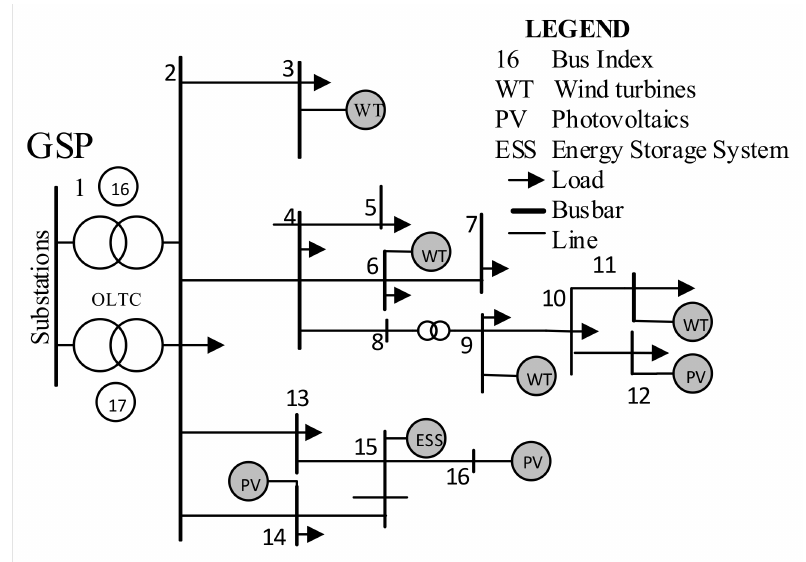
Figure 6. Single-line diagram of 16-bus UKGDS.